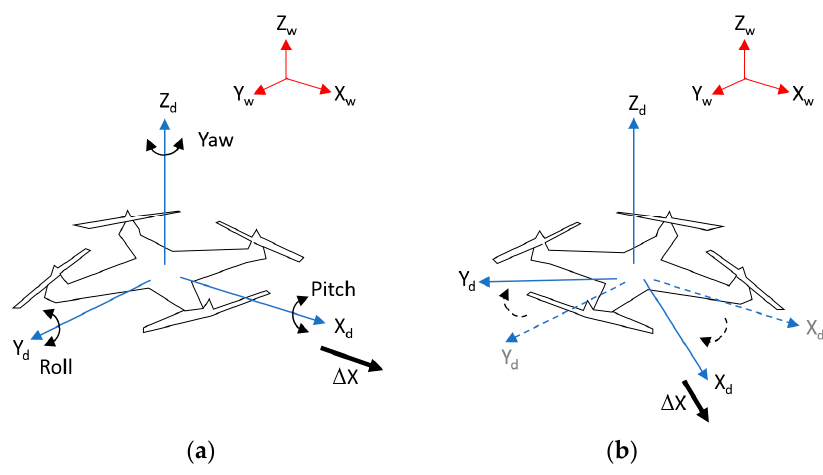
Figure 1. The two coordinates systems of drone and world ( a ) before changing the yaw of drone, ( b ) after changing the yaw of drone.